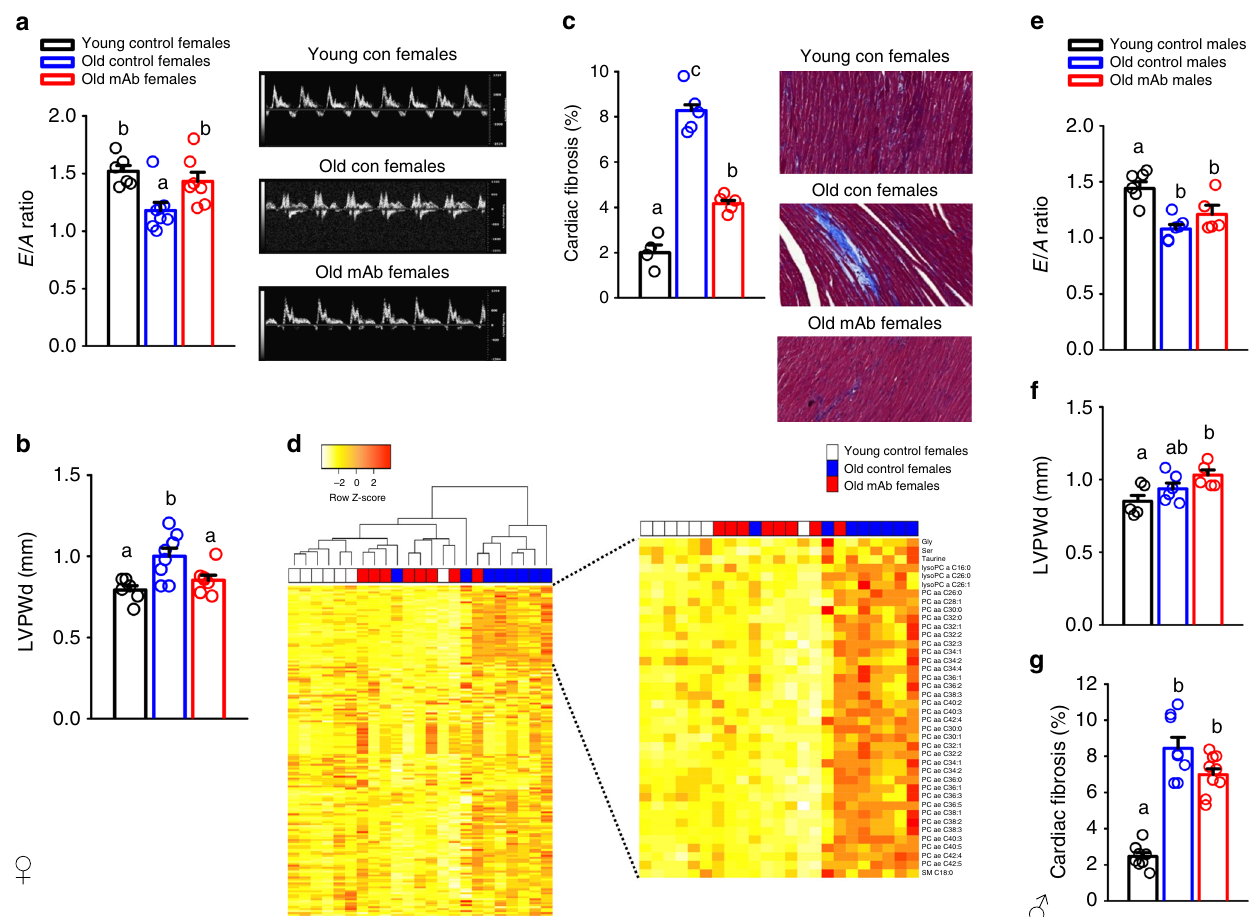
Fig. 4 L2-Cmu prevents age-related diastolic dysfunction in females. a – c Cardiac aging in CB6F1 female mice is characterized by a decline in diastolic function (E/A ratio), increased LVPWd, and accumulating amounts of fi brosis in the myocardium. However, 6 mo L2-Cmu treatment, beginning at 78 wks of age, was able to preserve diastolic function, reduce LVPWd measures in females [Young ( n = 6), Old Con ( n = 8), and Old mAb ( n = 7)], and largely prevented the accumulation of cardiac fi brosis [Young ( n = 4), Old Con ( n = 5), and Old mAb ( n = 6)]. d Metabolomic analysis of heart tissue in female mice [Young ( n = 7), Old Con ( n = 8), and Old mAb ( n = 7)] revealed that the young and aged metabolome are distinct (see also Supplementary Fig. 5), and predominantly characterized by differences in glycerophospholipids, and to a lesser extent ceramides, while amino acids, biogenic amines, and acylcarnitines were largely unaffected. However, mAb treatment tended to oppose the age-related alterations in several metabolites, including the rise of several glycerophospholipids, resulting in a more youthful metabolomic signature in heart. Further metabolomic data analyses can be found in in Supplementary Fig. 5 and the dataset here: [https://doi.org/10.17605/OSF.IO/8QGX9]. e – g Remarkably, the favorable effects of L2-Cmu in males were absent for E/A ratio [Young ( n = 5), Old Con ( n = 6), and Old mAb ( n = 5)] and fi brosis [Young ( n = 8), Old Con ( n = 8), and Old mAb ( n = 8)], suggesting that the bene fi cial effects of modulating IGF-1 signaling in heart is speci fi c to females. Bars represent mean ± s.e.m. Dot plots overlaid on bar graphs represent individual data points. Different letters denote a signi fi cant difference between groups by Tukey HSD, P ≤ 0.05